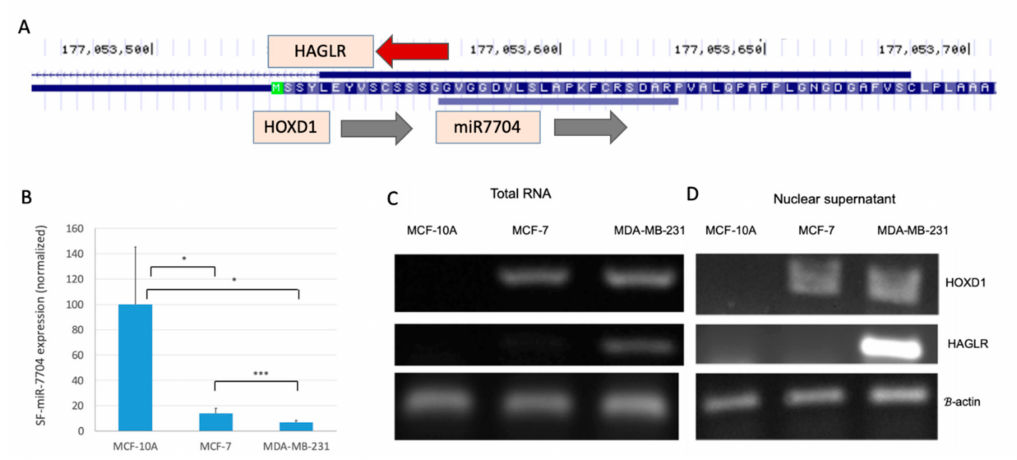
Figure 5. Inverse correlation between the expression of miR-7704 and HAGLR. ( A ) UCSC Genome browser view for miR-7704 indicates the overlap with HOXD1 and the lncRNA HAGLR. ( B ) Average expression levels and standard error of the mean (SEM) of miR-7704 from the SF from MCF-10A, MCF-7 and MDA-MB-231 cells. Pair statistics are marked for < 0.1 (*) and < 0.001 (***). Comparison of the results of RT-PCR assays of HOXD1 and HAGLR expression as measured from total RNA ( C ) and nuclear RNA ( D ) in the three tested breast cell-lines. Results shown are representative RT-PCR. The identity of the extracted bands was confirmed by DNA